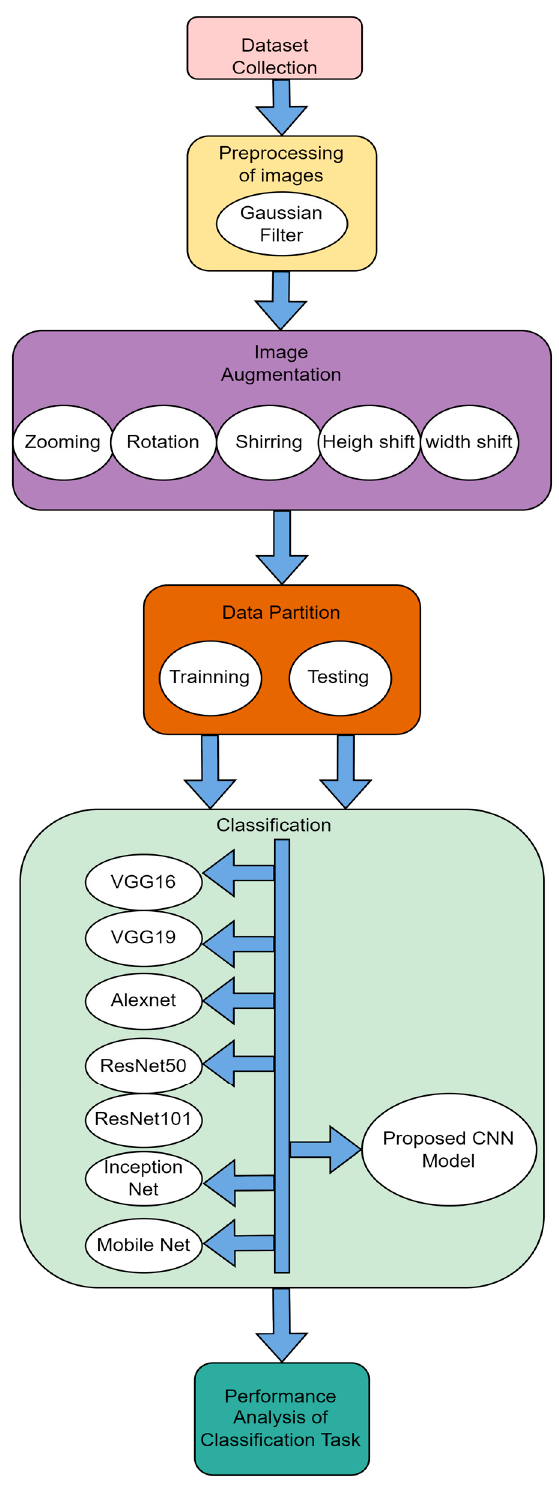
Figure 3. Proposed